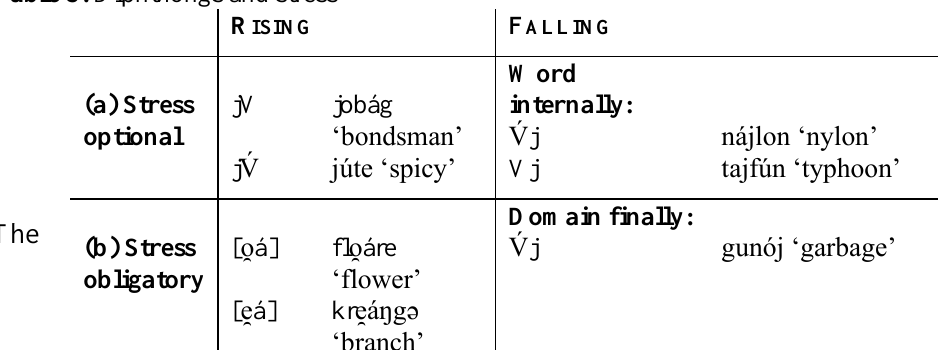
Table 3. Diphthongs and stress